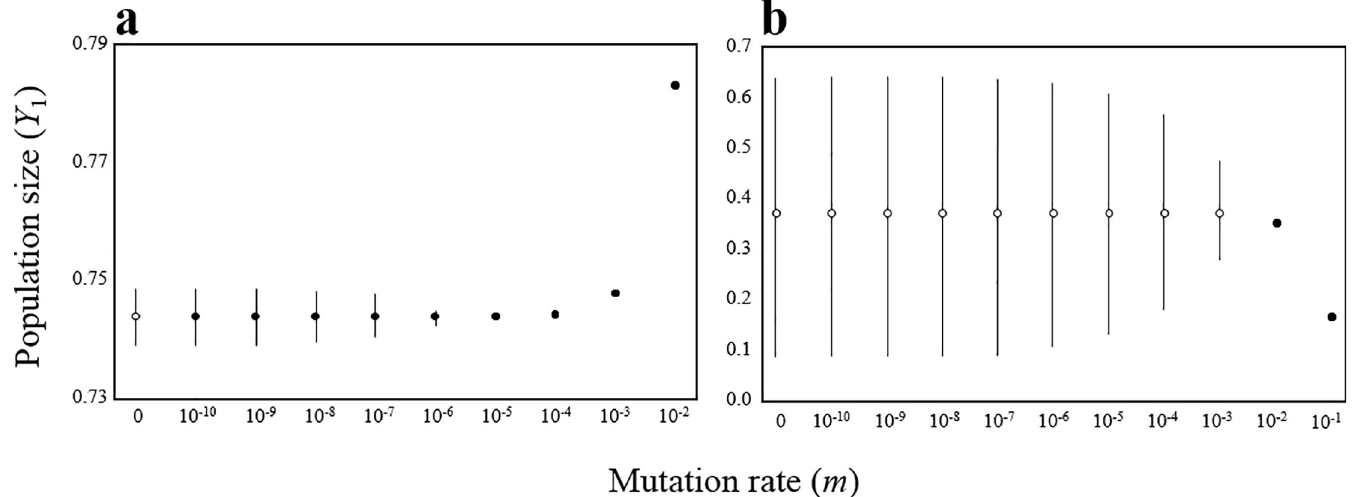
Fig 4. Population dynamics result in relation to the value of the mutation rate m . (a) a 11 = 0.8, a 12 = 1.0, a 21 = 1.0, and a 22 = 0.1 (other parameters are same as Fig 2E). (b) a 11 = 1.2, a 12 = 0.5, a 21 = 1.0, and a 22 = 0.1 (other parameters are same as Fig 2I). Open and closed circles indicate locally unstable and stable equilibrium, respectively. Bars indicate the oscillation ranges of population size Y 1 (the results of Y 2 have same tendency). Note that closed circles with bars are locally stable but globally unstable equilibrium. Equilibrium points are numerically obtained, and ranges of oscillations are obtained after sufficiently long periods (t = 10 7 ).